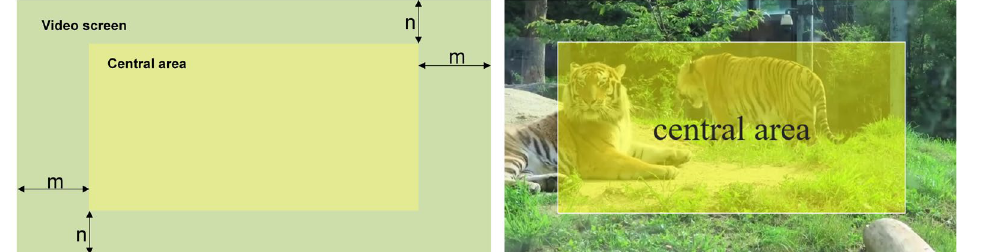
Figure 6. Schematic diagram of the division of the central area. The diagram on the left is an abstract representation, where we defined the central area as a fixed-scale area at the boundary of the video screen. The real situation is shown in the diagram on the right.